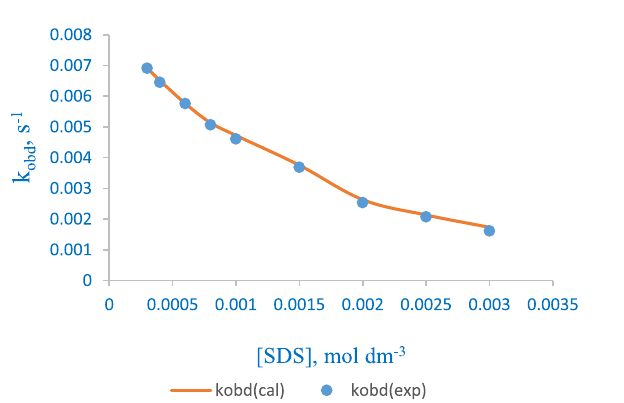
Figure 5. Plot of k obd against [SDS] fitted into Piszkiewicz’s equation for the reduction of [Mo IV O 2 (paoH) 2 ] 2− by S 2 O 4 2− .